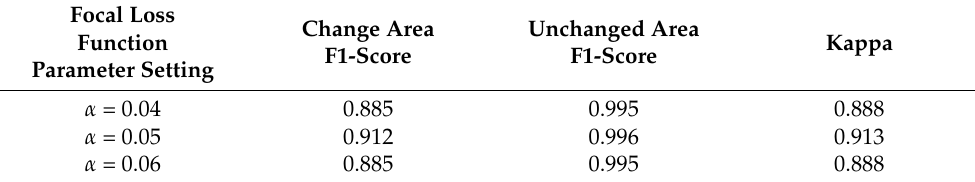
Table 2. Accuracy evaluation of the α model for determining parameters.